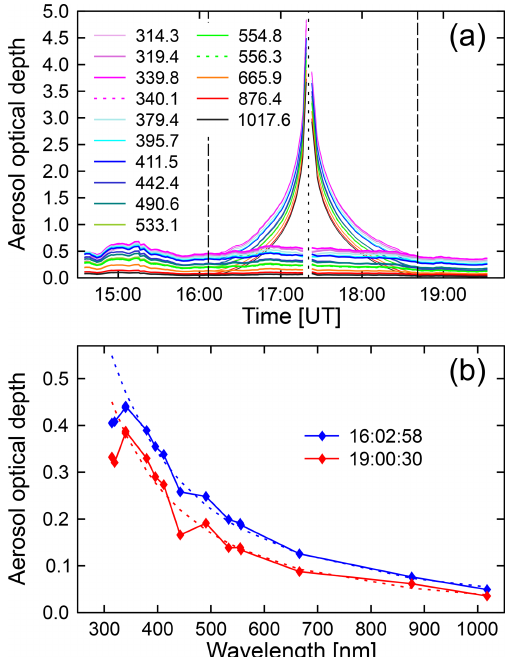
Figure 12. Aerosol optical depth. (a) AOD measured by the GUVis- 3511 radiometer at Smith Rock as a function of time. Thin lines indicate AODs measured without LD correction, while thick lines indicate AODs corrected using the LD parameterization by Pierce. Long-dashed lines indicate the start and end times of the eclipse, and the short-dashed line indicates the time at totality. Without LD correction, the reduced irradiance during the eclipse period is in- correctly attributed to aerosols, leading to a spurious spike at the time of totality. With LD correction, the effect of the eclipse is not noticeable in the AOD data. The legend indicates the centroid wave- lengths of the GUV’s channels. (b) Aerosol optical depth as a func- tion of wavelength shortly before (16:02:58) and after the eclipse (19:00:30). Dashed lines indicate Ångström function fits to the data based on measurements of the AODs between 339.8 and